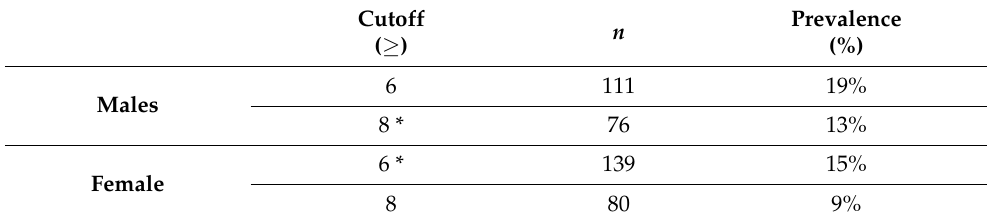
Table 2. Distribution of alcohol-related problems based on gender when applying cutoffs of 6 and 8 points on AUDIT total scale ( n = 582 males; n = 901 females).